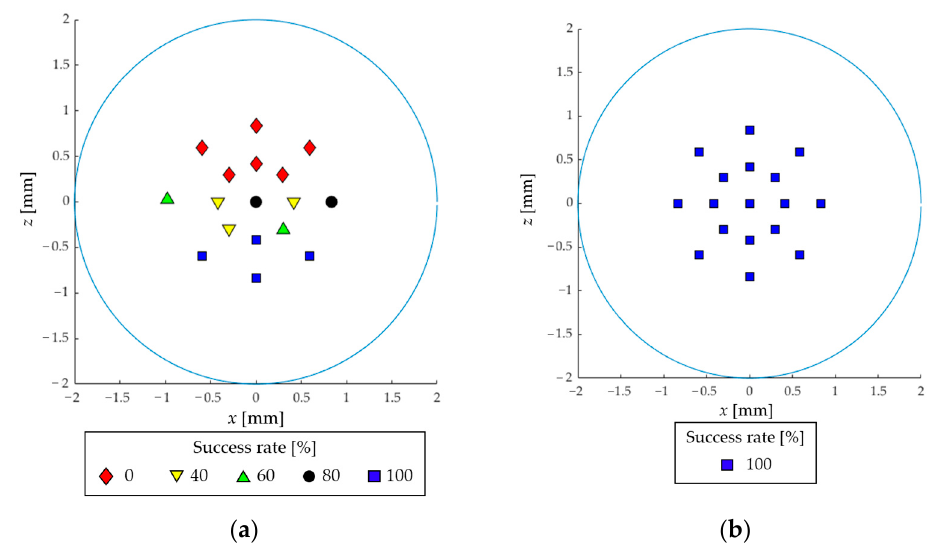
Figure 13. ( a ) Success rate of recombination of the UMR with the delivery catheter without applying magnetic force; ( b ) with applying magnetic force.